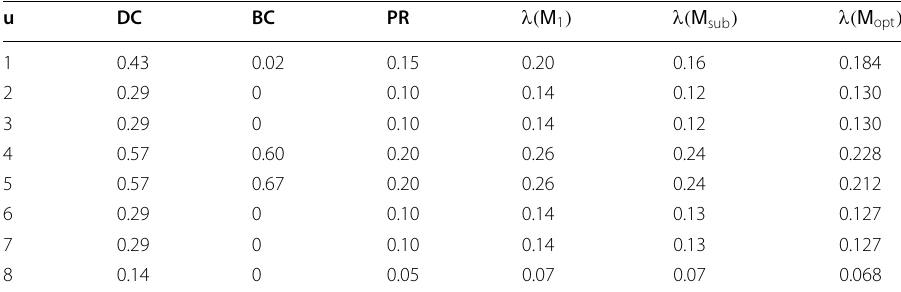
Table 1 Rounded centrality scores for the toy network: degree centrality (DC), betweenness centrality (BC), PageRank without teleportation (PR), and map equation centrality ( (cid:31) ) for the one- level partition M 1 , a sub-optimal partition M sub , and the optimal partition M opt , shown in (Fig.